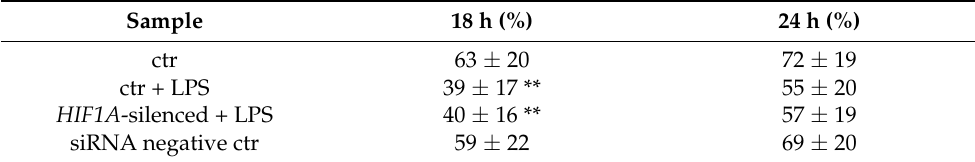
Table 2. Wound healing assay in